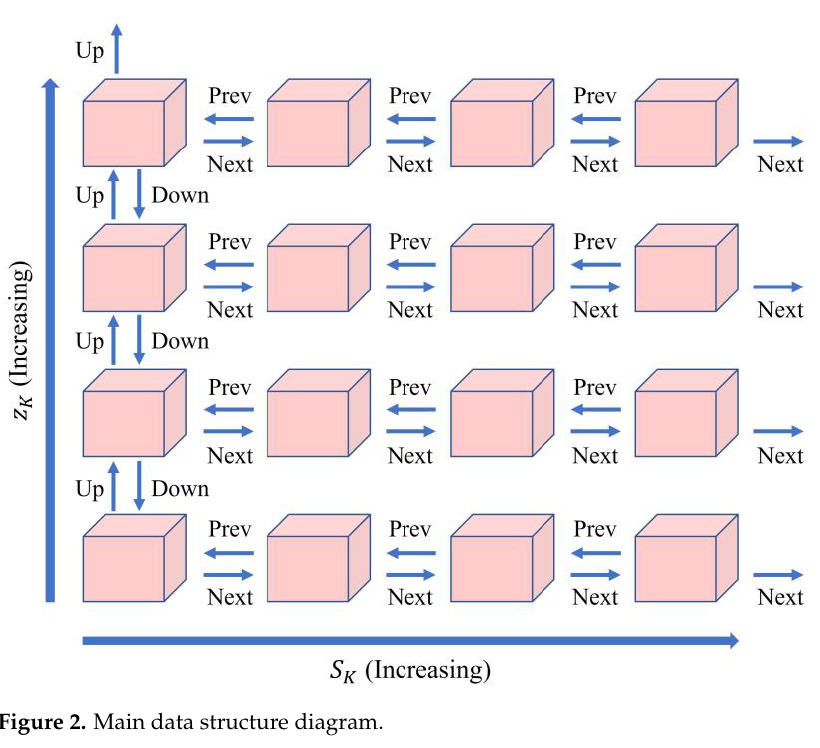
Figure 2. Main data structure diagram.